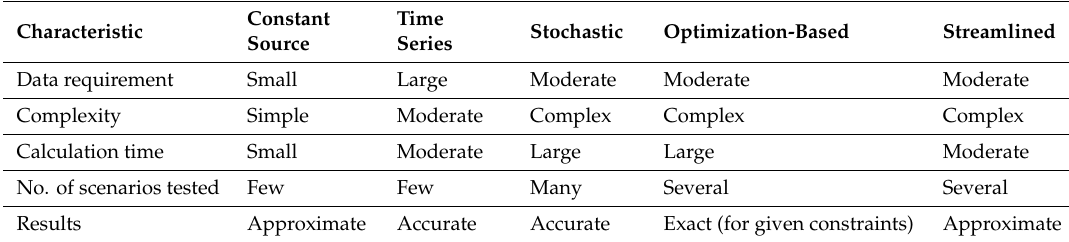
Table 6. Comparison of the HC calculation